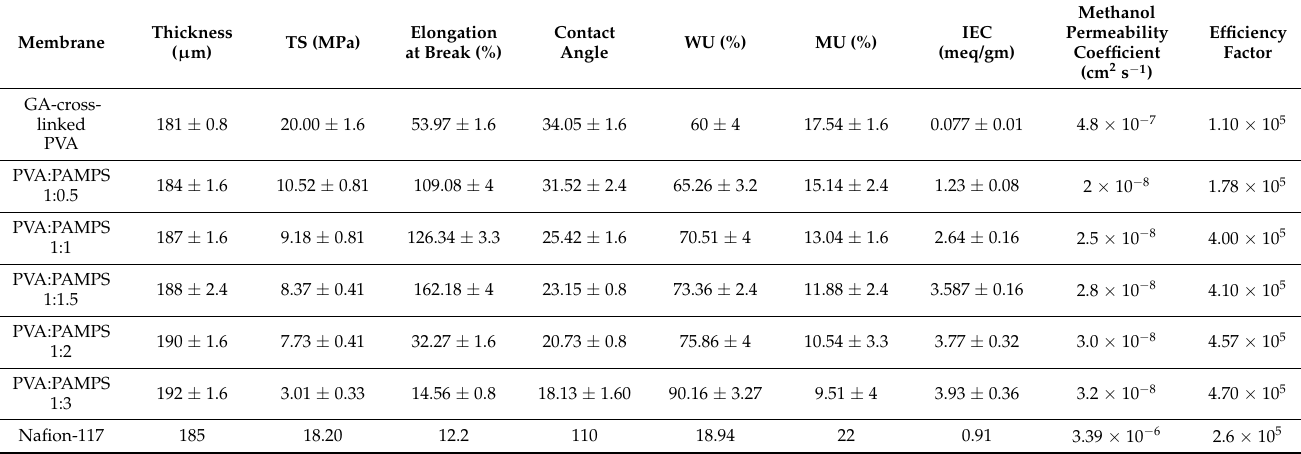
Table 2. Thickness, tensile strength, elongation at break, contact angle, WU, MU, IEC, methanol permeability, and efficiency factor of the GA-cross-linked PVA and PVA/PAMPS blend-based membranes.